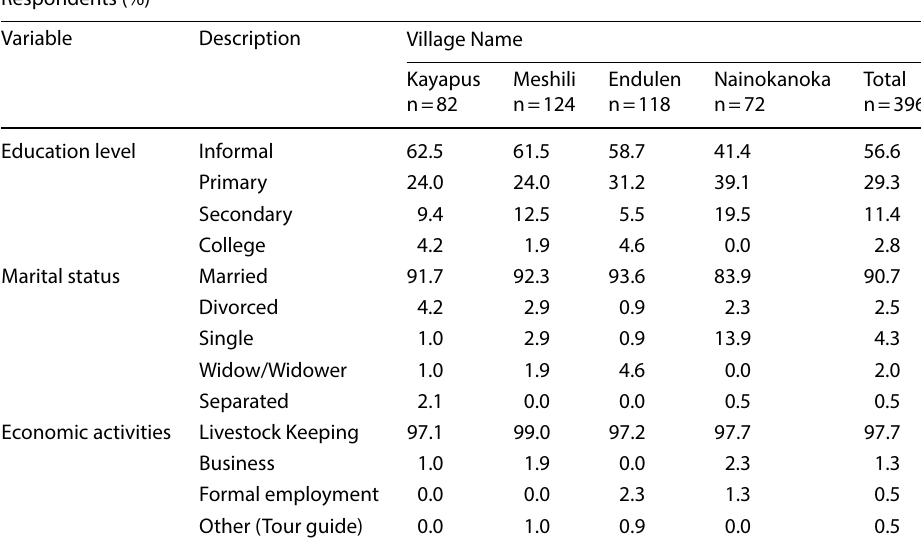
Table 1 Education level, Marital status, and Economic activities of the